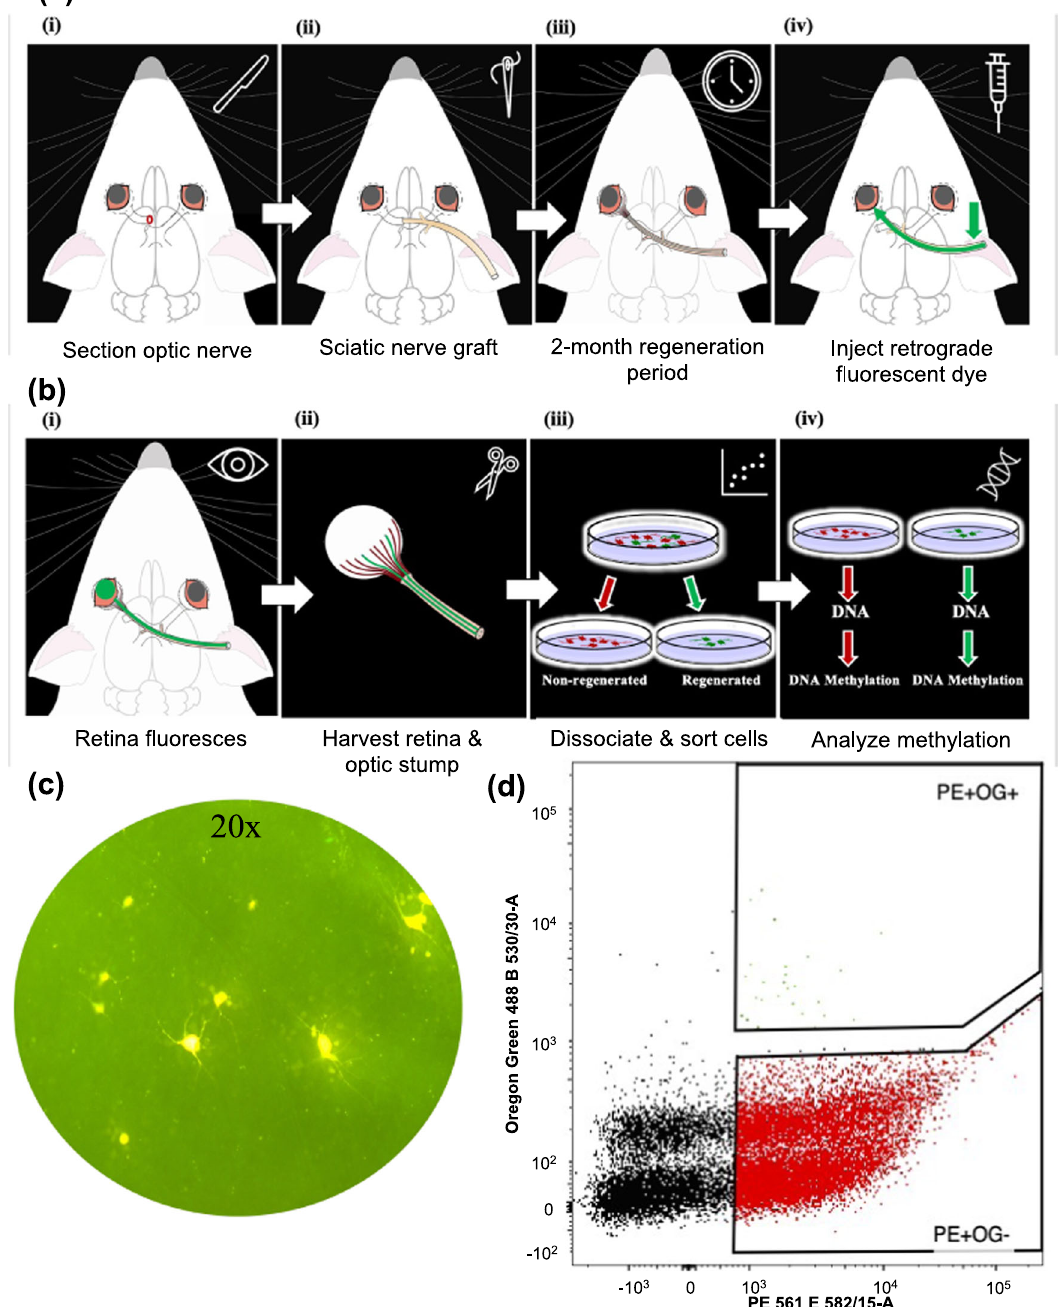
Fig. 2 Schematic of the experimental paradigm and the neuronal isolation protocol. a (i) Six-week-old rats were anesthetized, and the optic nerve of the left eye was sectioned. (ii) A portion of the sciatic nerve was grafted to the optic stump. (iii) An eight-week period was allowed for injured RGCs to regenerate axons to reach the sciatic nerve graft. (iv) In animals to be used for phenotyping (quantitation of RGC regeneration), the free end of the graft was back fi lled with the retrograde tracer Fluorogold (see C). In animals used for cell sorting, the free end of the graft was back fi lled with the retrograde tracer Oregon green. b (i) Fluorescent retina. (ii) The retina and optic stump destined for cell sorting were harvested. (iii) RGCs were dissociated and stained with the neuronal Thy-1 marker conjugated to fl uorescent R- Phycoerythrin (Thy-1 R-PE). Dead cells were removed using DAPI, and the live cells were sorted with FACS. Red arrow — sciatic nerve; blue arrow — green- fl uorescent tracer (Oregon green) application site. (iv) Following cell sorting and puri fi cation of regenerated and non-regenerated RGC populations, DNA was extracted from cells and used to investigate DNA methylation pro fi les. c The retina destined for phenotyping was harvested, fl at-mounted, and visualized under a fl uorescence microscope. A representative image (×20) of the retina with fl uorescent RGCs (Fluorogold-positive) indicating that they regenerated axons to the end of the graft. (d) A scatterplot shows the distribution and abundance of dead cells (black dots), live injured/regenerated (IR) RGCs (green dots; Thy-1 R-PE + ; OG + ), and live injured/non-regenerated (INR) RGCs (red; Thy-1 R-PE + ; OG − ) across the red (x-axis) and green ( y axis) fl uorescent